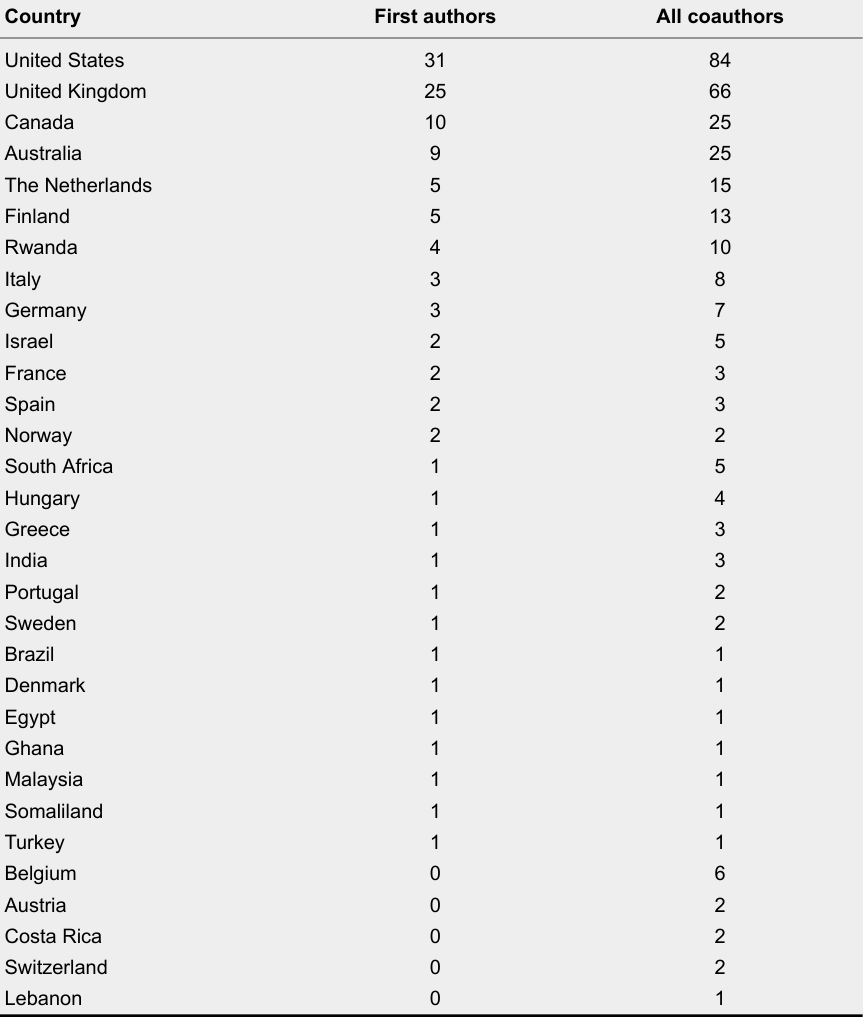
Location of the Authors Who Published in JSPP Between 2013 and 2016